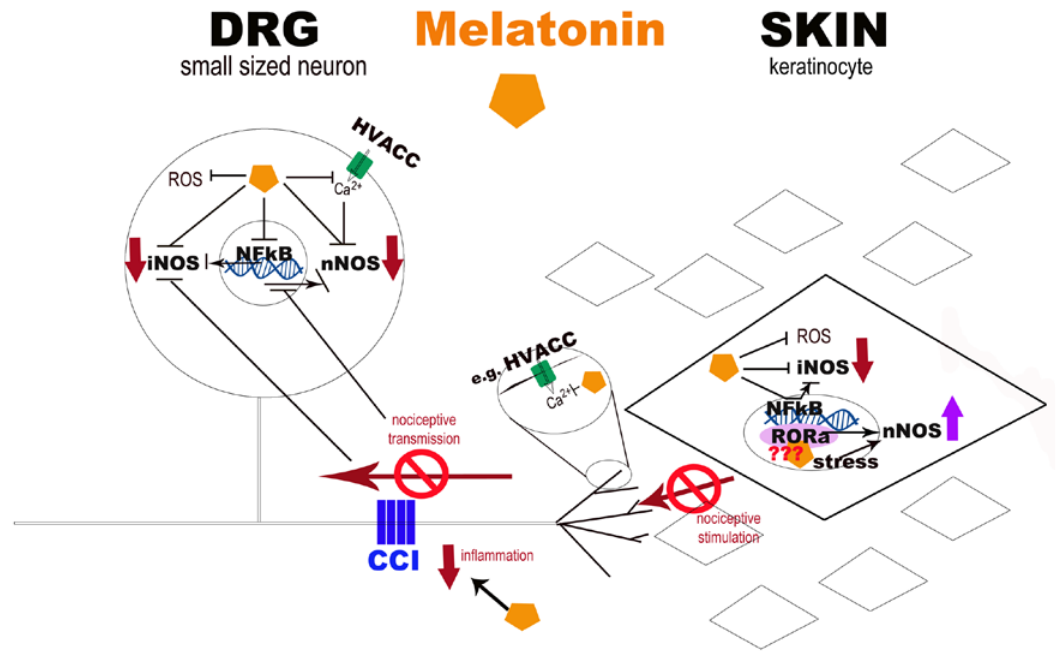
Figure 8. Schematic diagram of potential melatonin pathways at the skin and DRG levels. The diagram represents the potential pathways undergoing the beneficial effect of melatonin in neuropathic pain conditions at skin and DRG levels. Melatonin is highly lipid soluble, and readily crosses the plasma membrane to enter the cell; it has access to cytosolic, mitochondrial, and nuclear compartments. Through its radical scavenging action, it protects the cells from free radicals, such as nitric oxide (NO) and reactive oxygen species (ROS), and decreases the neurotransmitters/neuromodulators production, which leads to the nerve fibres excitation. So, the beneficial effect of melatonin at the skin level could also affect the sensory nerve terminals influencing the nociceptive transmission. Melatonin may also inhibit directly the catalytic activity of nitric oxide synthase (NOS) and modulate NOS expression. In particular, iNOS expression is reduced through the inhibition of the transcription factor nuclear factor-kappa B (NF- κ B), both at the DRG and in keratinocytes. Regarding nNOS, at the skin level, we presume that its increased expression in sham-operated animals treated with melatonin (10 mg/kg) may be probably due to the melatonin interaction with ROR α receptor, even if it has not yet been identified in the rat, and only in the mouse. At the DRG level, nNOS upregulation seems to represent a general response of neuronal cells to stress, including nerve injuries, as in chronic constriction injury model (CCI). Moreover, melatonin may reduce the intracellular calcium rise by inhibiting, for example, high voltage activated calcium channels (HVACC), and thereby inhibiting also nNOS